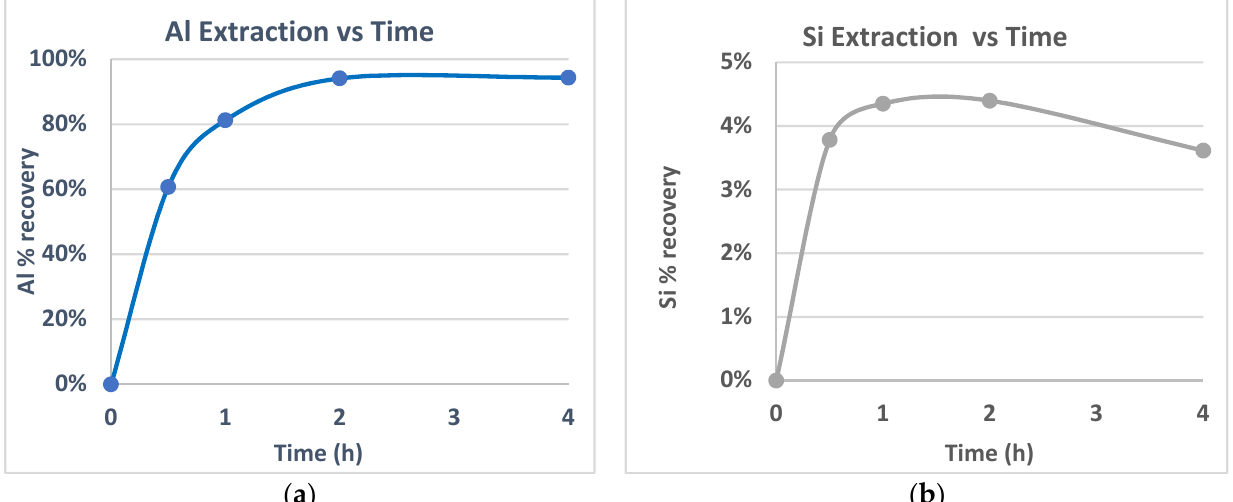
Figure 2. Effect of low molarity concentration of agent on the extraction of ( a ) Al, and ( b ) Si values from SB metakaolin (stirring rate: 300 rpm, HCl concentration: 1 M, temperature: 90 °C, retention time: 4 h).